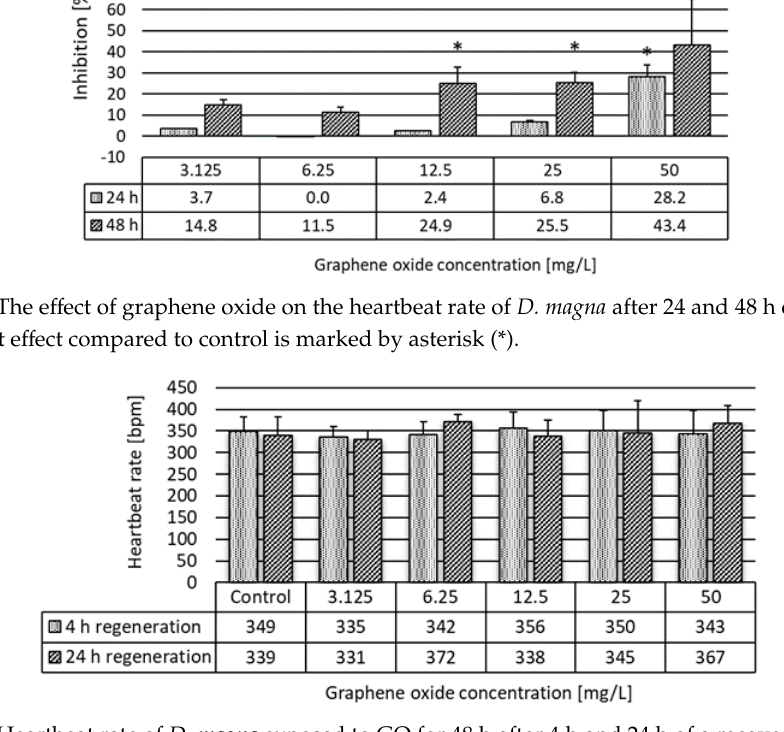
Figure 7. Heartbeat rate of D. magna exposed to GO for 48 h after 4 h and 24 h of a recovery period in clean growth medium.